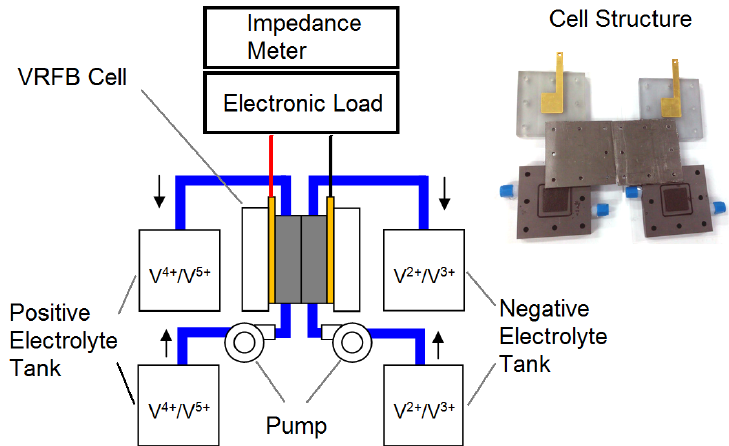
Figure 1. Schematic of the experimental setup and a photo of the vanadium redox flow battery (VRFB) cell in this study.